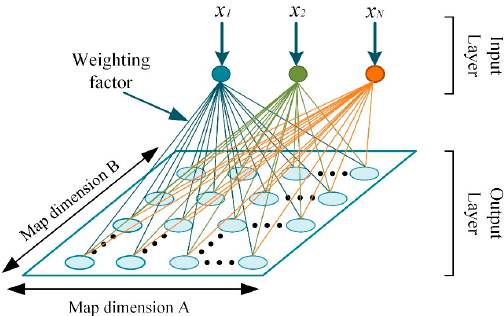
Figure 4. Structure of the self-organizing Kohonen map—SOM.